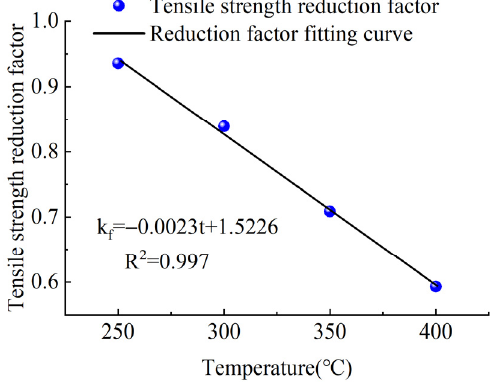
Figure 6. Reduction coefficient of tensile strength.